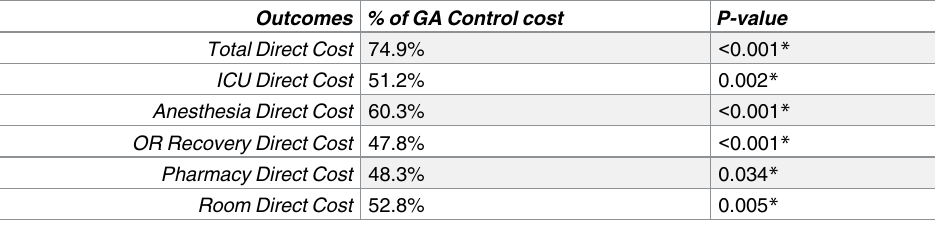
Table 9. Conscious sedation cost outcomes, matched patients excluding Sapien 1 valves and transa- pical